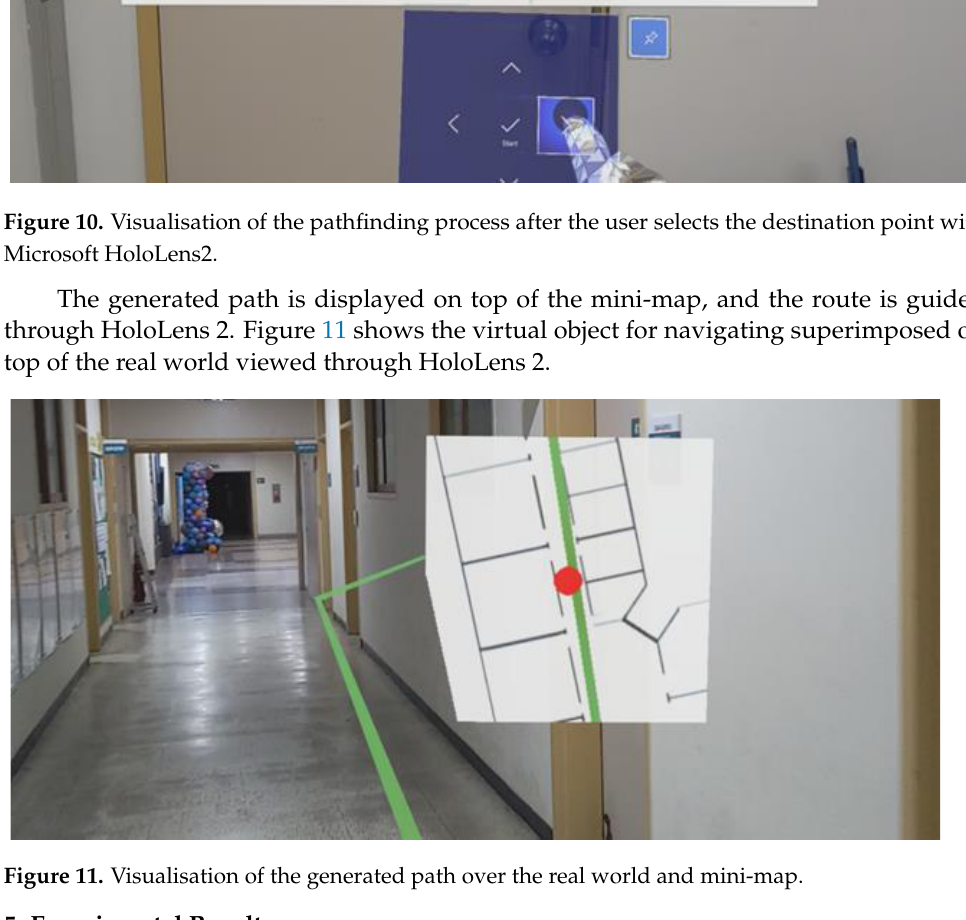
Figure 11. Visualisation of the generated path over the real world and mini-map.